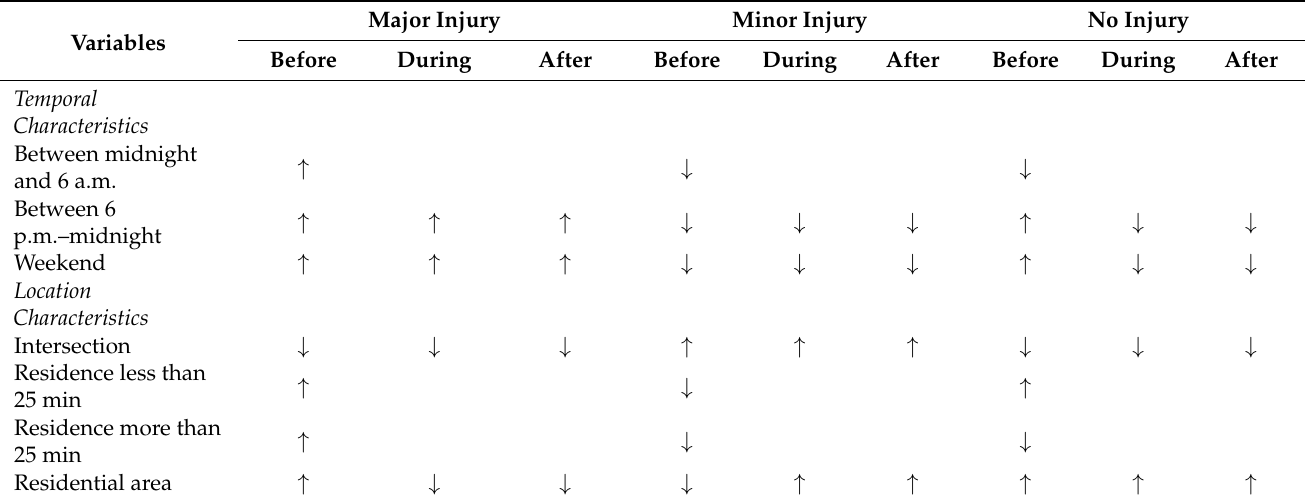
Table 6. Comparison of marginal effects of significant variables across the three